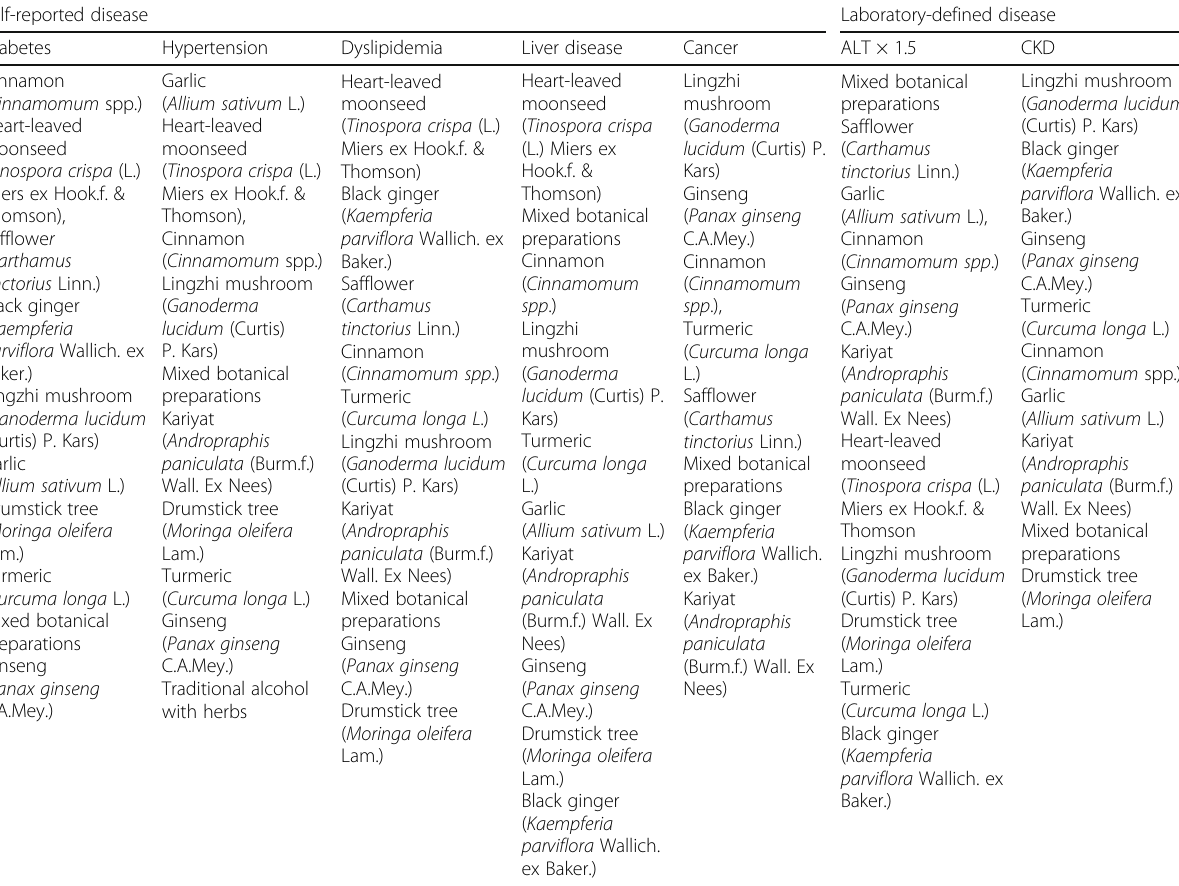
Table 3 Top ten herbal and traditional medicine according to self-reported conditions or laboratory defined diseases Self-reported disease